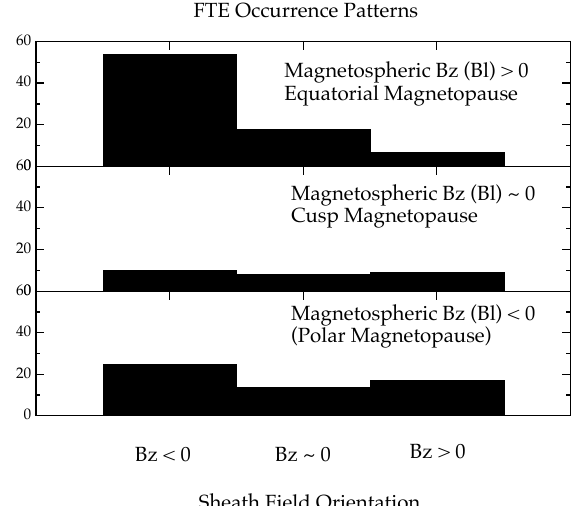
Fig. 10. Results of a statistical study of event occurrence versus magnetosheath magnetic field orientation at three locations on the magnetopause. Events on the equatorial magnetopause exhibit a strong tendency to occur for southward magnetosheath magnetic field orientations. Events in the cusp show no tendency to occur for northward or southward magnetosheath magnetic field orienta- tions. Events on the polar magnetopause show a weak tendency to occur for both strongly northward and southward magnetosheath magnetic field